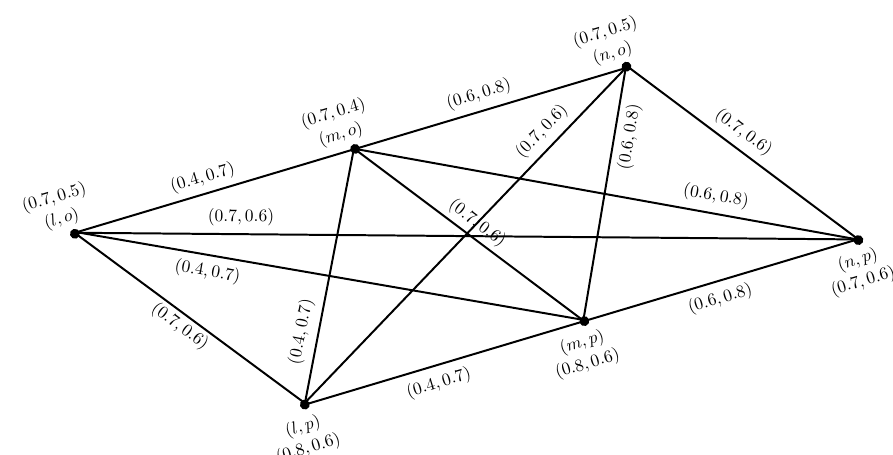
Figure 8. Lexicographic product of two